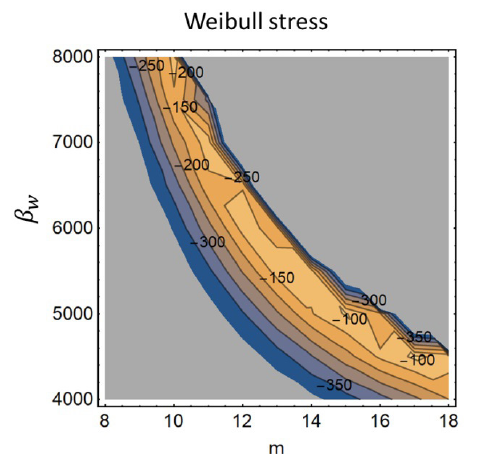
Figure 9. Likelihood pattern for the Weibull distribution.